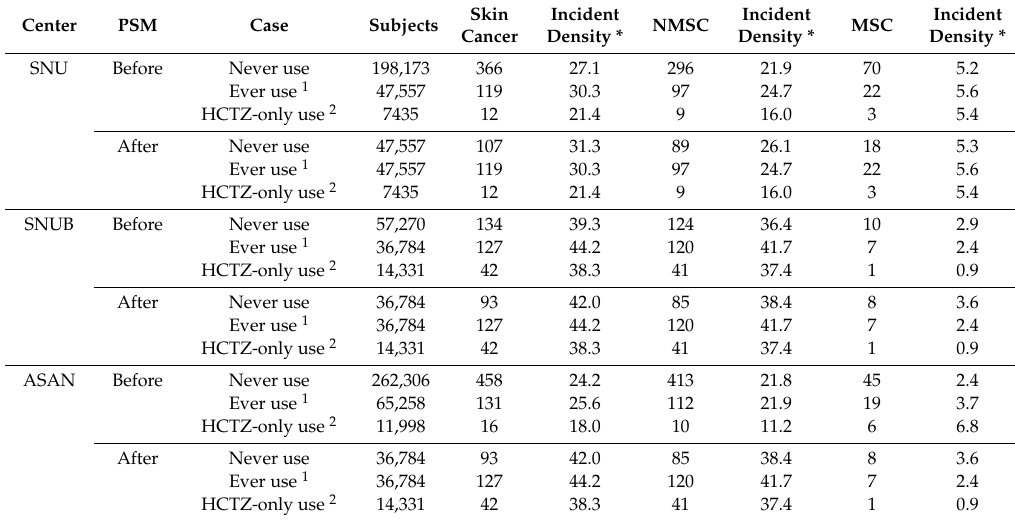
Figure 1. The flowchart of study participants in the CDM network. Table 1. Number of Skin Cancer Cases in the Study Participants before and after Propensity Score Matching.